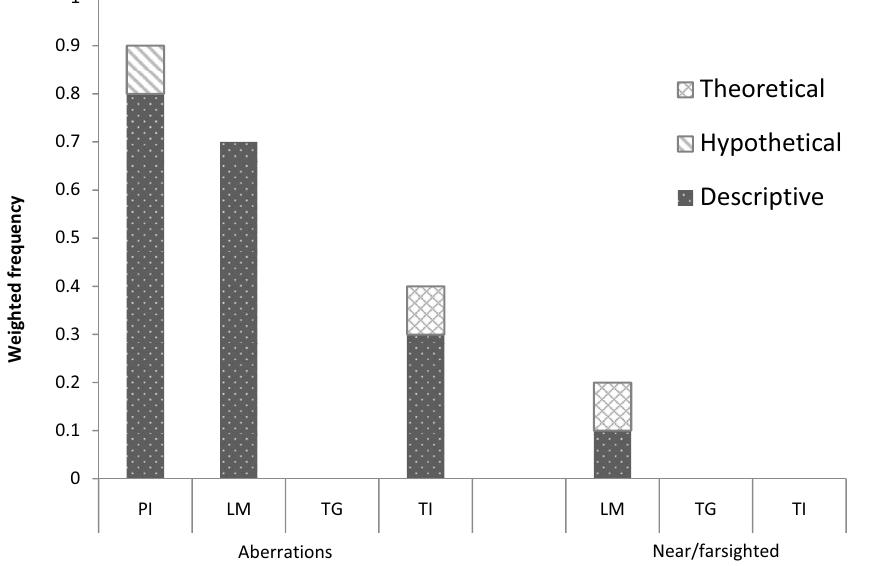
FIG. 5. Unlinked concepts used, sorted by participant